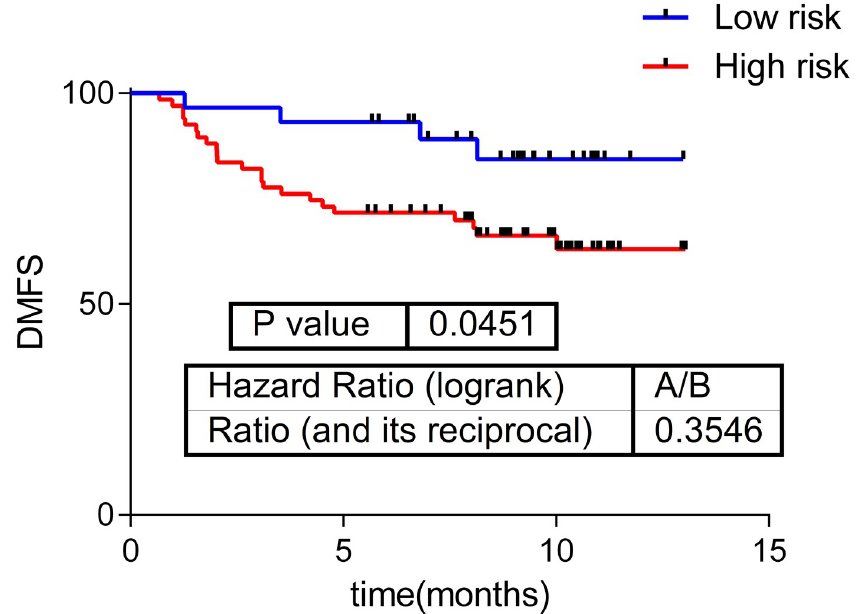
Fig 2. Component 13 activity prognostic value in the whole cohort.